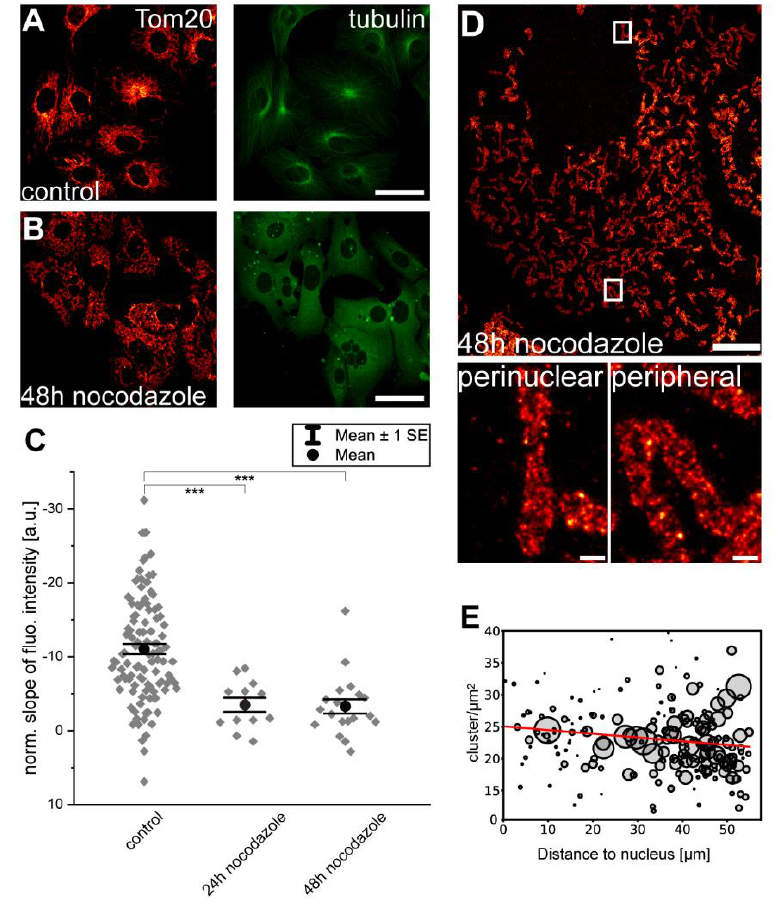
Figure 3. An intact microtubule-cytoskeleton is necessary for the maintenance of inner-cellular Tom20 protein abundance gradients. Cells were mock-treated ( A ) or incubated for 48 h with the microtubule depolymerizing compound, nocodazole ( B ). Cells were labeled with an tisera against α -tubulin and Tom20. ( C ) Normalized slopes of the fluorescence intensity gradients of control and nocodazole treated cells decorated with antiserum against Tom20. For the analysis, overlapping mitochondria were excluded. Each grey rhomb represents one cell. Black dot: mean. Error bars: Standard error of the mean. *** P = 0.001 (paired t test analysis). ( D ) STED image of a cell treated for 48 h with nocodazole and labeled with antiserum against Tom20. Overview image (top) and magnifications of perinuclear mitochondria and peripheral mito- chondria from the indicated areas. ( E ) Analysis of the Tom20 cluster density in ( D ). Each sphere represents one mitochon- drion within the image. The size of the spheres corresponds to the area of the mitochondrion. Scale bars: 0.5 µm ( D : mag- nifications), 10 µm ( D : overview), and 40 µm ( A , B ).